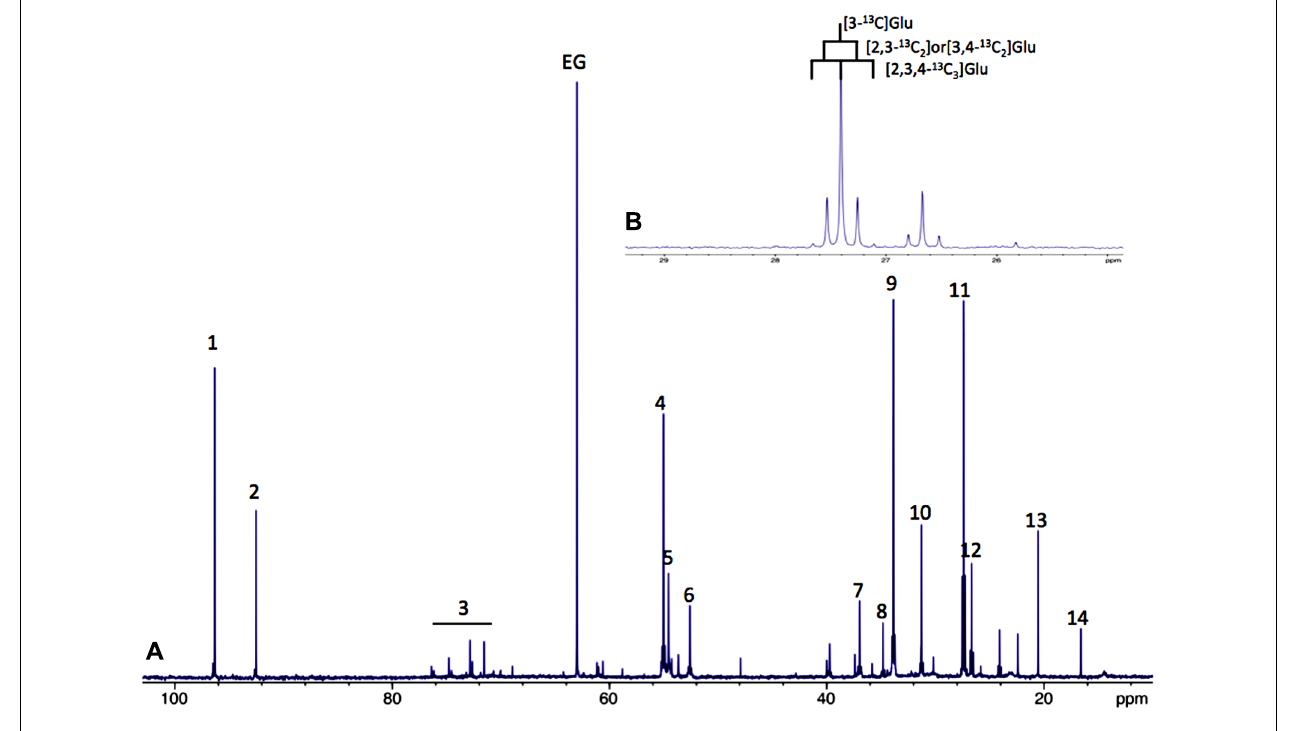
FIGURE 1 | (A) Typical 13 C-NMR spectrum of rat brain perchloric extract, after perfusion with [1- 13 C]glucose. (1) Glucose C1 α , (2) glucose C1 β , 3: glucose C2, C3, C4, C5 and C6, 4: Glu C2, 5:Gln C2, 6: Asp C2, 7: Asp C3, 8: GABA